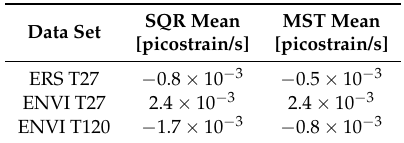
Table 2. Mean for SqueeSAR (SQR) and minimum spanning tree (MST) stack gradients for each satellite track.